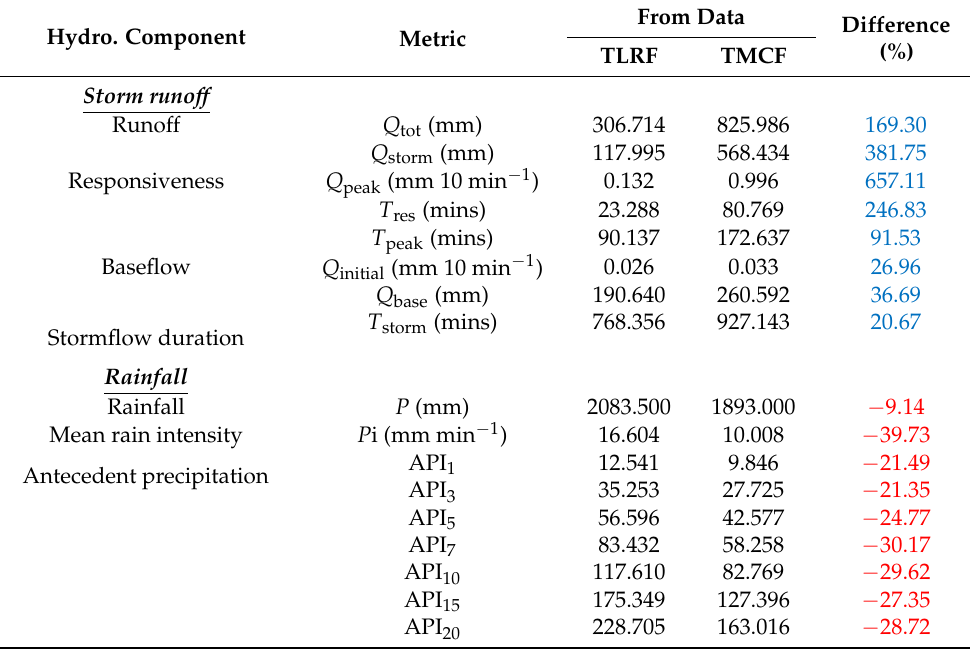
Table 3. Comparison of hydrograph metrices between the TMCF and the TLRF.